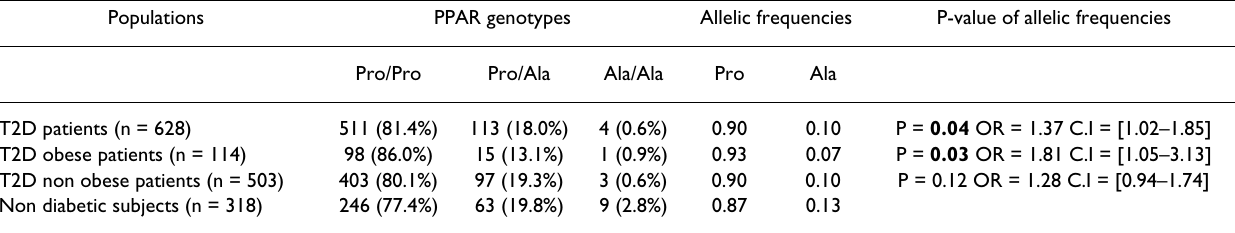
Table 3: Comparison of Genotypic and Allelic Distribution of Pro12Ala polymorphism in diabetic versus non diabetic subjects. Case/ Control studies show the association of the Pro12Ala polymorphism with T2D in the French Caucasian population (p = 0.04). The stratification of diabetic subjects on the obesity status shows that the association previously found is rather due to obese T2D subgroup (p = 0.03) than non obese T2D subgroup (p = 0.12). Populations